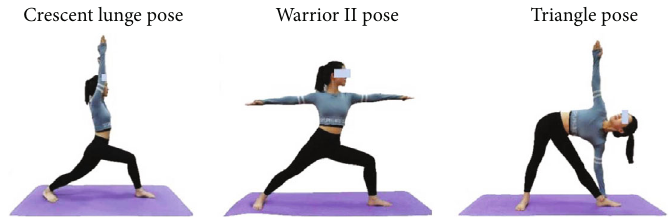
Figure 1: Three typical yoga manoeuvres. Table 1: Mean and standard deviation for peak joint angles and range of motion ( ° ) in the sagittal and frontal